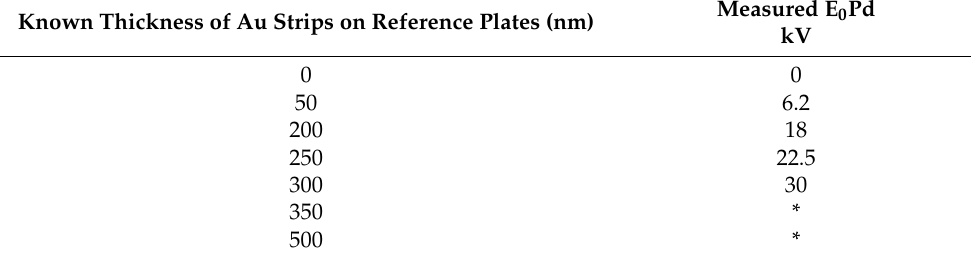
Table 2. The E 0 Pd signals for the seven Au strips on the reference plates. Known Thickness of Au Strips on Reference Plates